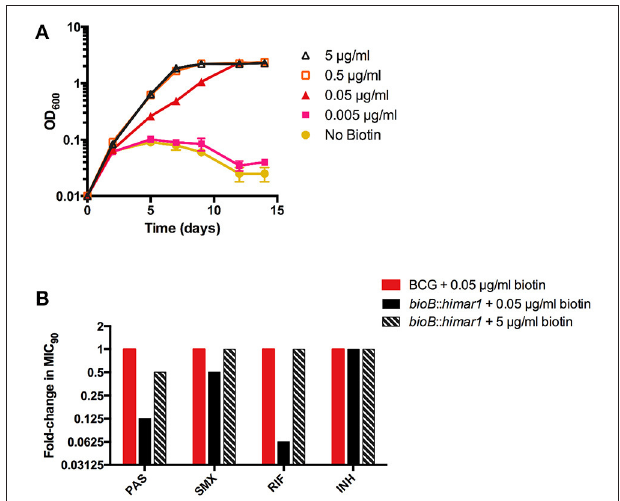
FIGURE 5 | Disruption of bioB is growth inhibitory and potentiates drug action. (A,B) M. bovis BCG bioB :: himar1 was grown to an OD 600 of ∼ 0.5, washed three times to remove residual biotin with biotin-free 7H9 medium, and resuspended in biotin-free 7H9 medium to a starting OD 600 of 0.01. Cultures were then supplemented with biotin and incubated for 14 days with OD 600 readings taken at the given time points. Error bars denote standard deviation and are representative of 2 separate experiments. (B) M. bovis BCG and bioB :: himar1 were grown to an OD 600 of ∼ 0.5, washed three times to remove residual biotin, and resuspended in biotin-free 7H9 medium to a starting OD 600 of 0.01. Cultures were then supplemented with biotin (0.05 and 5) and incubated for 14 days with OD 600 readings taken at the given time points. MIC 90 is defined as the minimum concentration of inhibitor required to restrict at least 90% of growth relative to growth seen in the no-drug control cultures. PAS, para -aminosalicylic acid; SMX, sulfamethoxazole; RIF, rifampin; INH, isoniazid. Results shown are representative of 3 separate experiments.